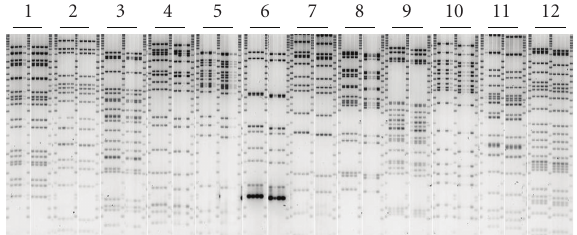
Figure 3: Fingerprinting of BAC clones 1–12. For each of the 96 BAC clones, 8 isolates were fingerprinted with EcoRI. Due to the gel loading procedure, only 4 clones could run next to each other. Multiple gel photos were assembled into one panel for ease in